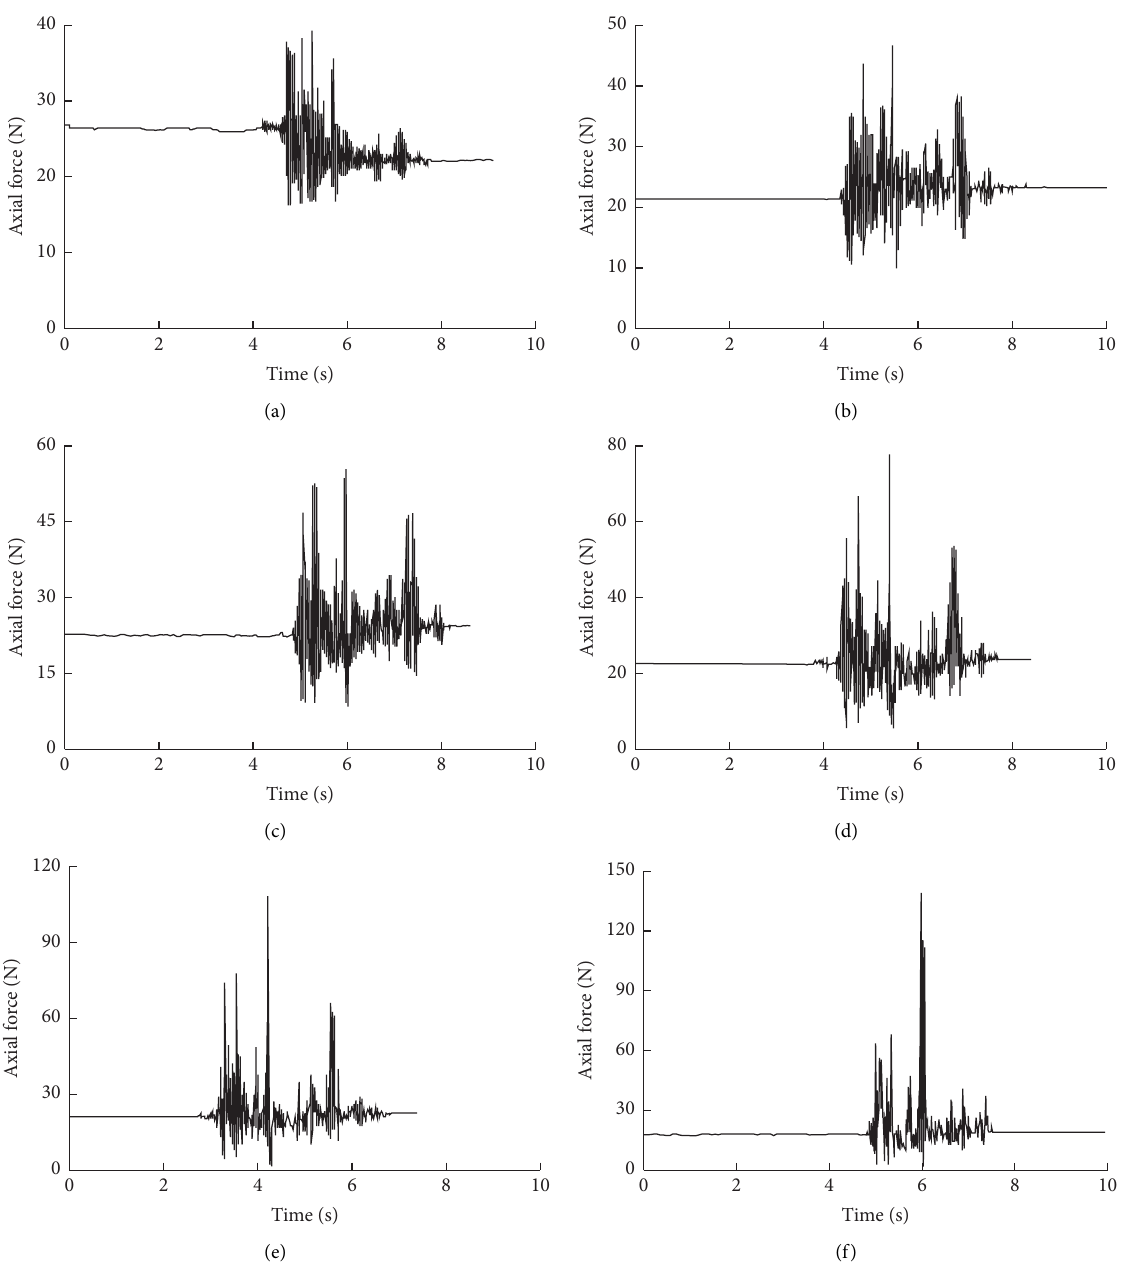
Figure 8: Time histories of 2# anchor cable under seismic motions with the amplitude of (a) 0.15g; (b) 0.30g; (c) 0.40g; (d) 0.50 g; (e) 0.70g; (f)